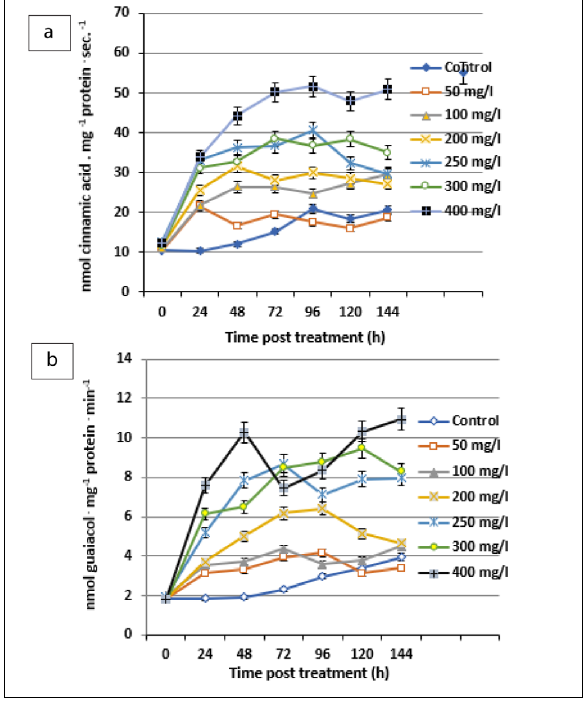
Figure 6: (a) Phenylalanine ammonia lyase and (b) polyphenol oxidase time course of modulation activities in chitosan nanoparticle treated plants compared to untreated control plants. Values are mean±s.e. of three repeats ( p ≤0.05). plants was high, with 10.26- and 9.56-relative expression fold increases, respectively, over the untreated control